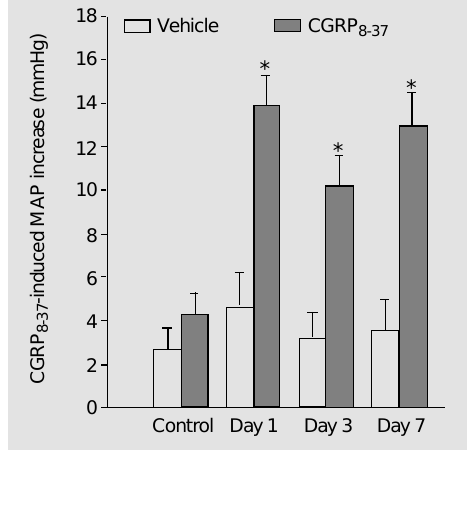
Figure 5. Northern blot analysis of RNA samples from the control and nerve growth factor-treated spontaneously hypertensive rats. A , Total cellular RNA samples were fractionated on denaturing formaldehyde-agarose gel and transferred to a nylon membrane. The membrane was hybridized with the 32 P-labeled calcitonin gene-related peptide (CGRP) ge- nomic DNA insert. The CGRP probe was removed from the membrane, which was subse- quently hybridized with the 32 P- labeled 18S rRNA probe. After hybridization with each probe, the membrane was washed and placed in a phosphor screen cas- sette. The exposed phosphor screen was then placed in a phos- phor imager to quantify the hy- bridization signals as shown in panel B. *P<0.05 compared to control animals (ANOVA followed by the Tukey-Kramer multiple comparisons test).